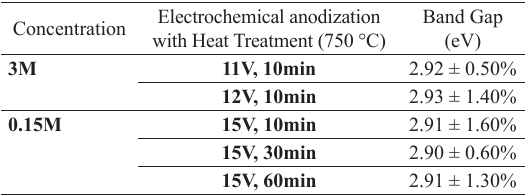
Table 2. Band Gap Values obtained through absorbance with the Tauc-Plot method with the thermally treated anodized samples. Electrochemical anodization Concentration with Heat Treatment (750